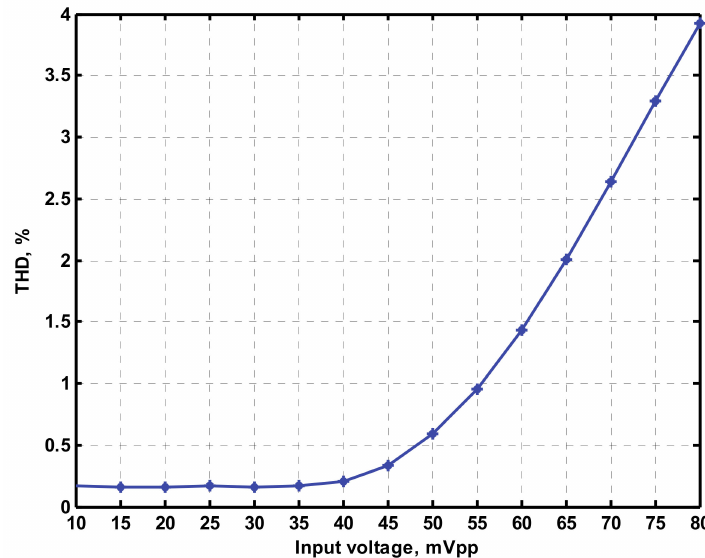
Figure 17. THD variations of the BPF against applied input voltages.